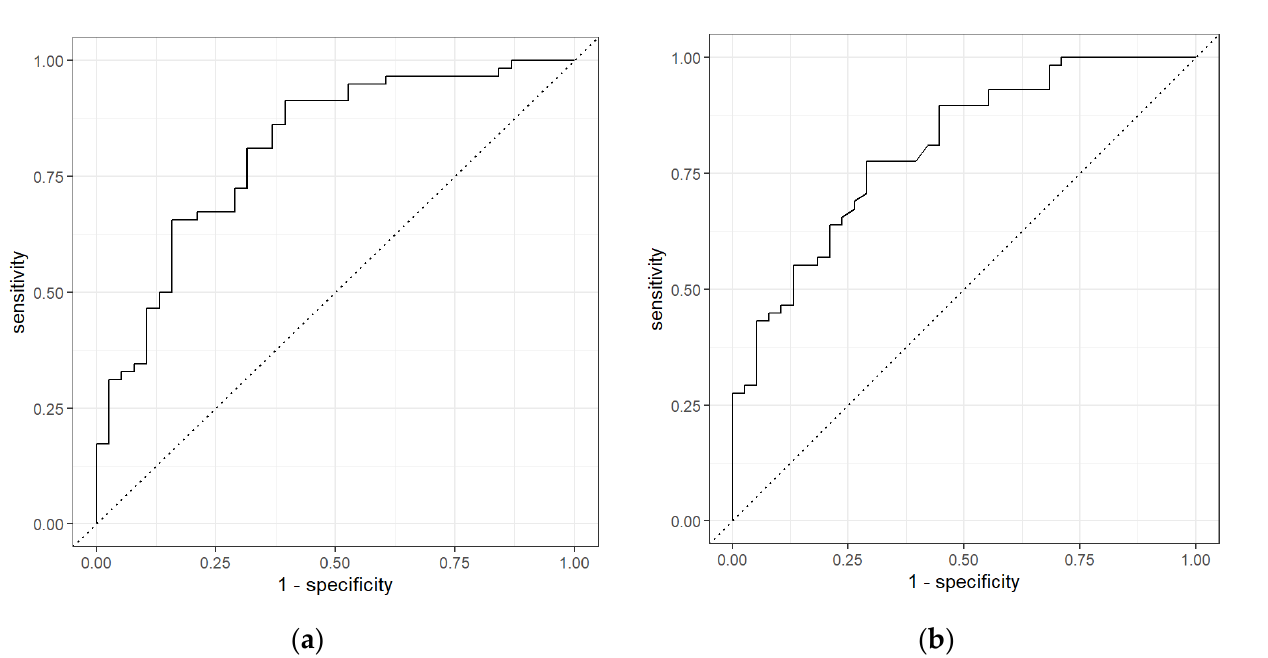
Figure 6. Output from the GC-TOF-MS to a late CRC urine sample with each peak representing the abundance of the chemicals at retention time. GC-TOF-MS shows a very high separation among the two groups, as shown in Table 4. The results illustrate that GC-TOF-MS was able to separate cancer and non-cancerous groups with a very high sensitivity and specificity.